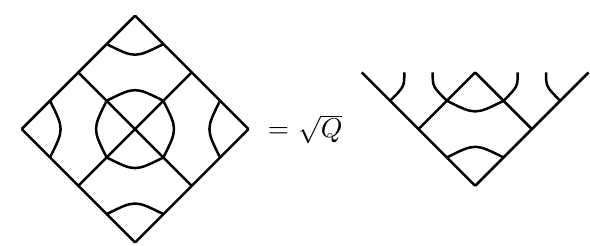
p = Qe i . Multiply- i